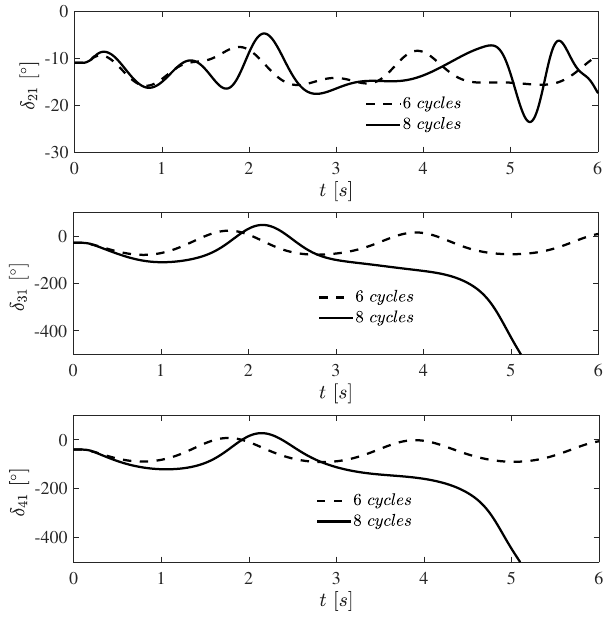
Figure 5. Angular difference of each machine with respect to number one, electrical grid without StatCom neither